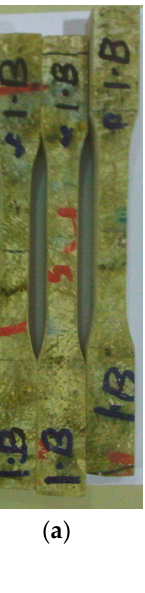
Figure 8. (a) Prepared specimens machined along the hoop direction; ( b ) Failed specimen showing matrix cracking, fiber debonding, and huge delamination between the straight pipe and the overwrapped fiber breakage; ( c ) Flexural stress–strain curve of hoop specimens.